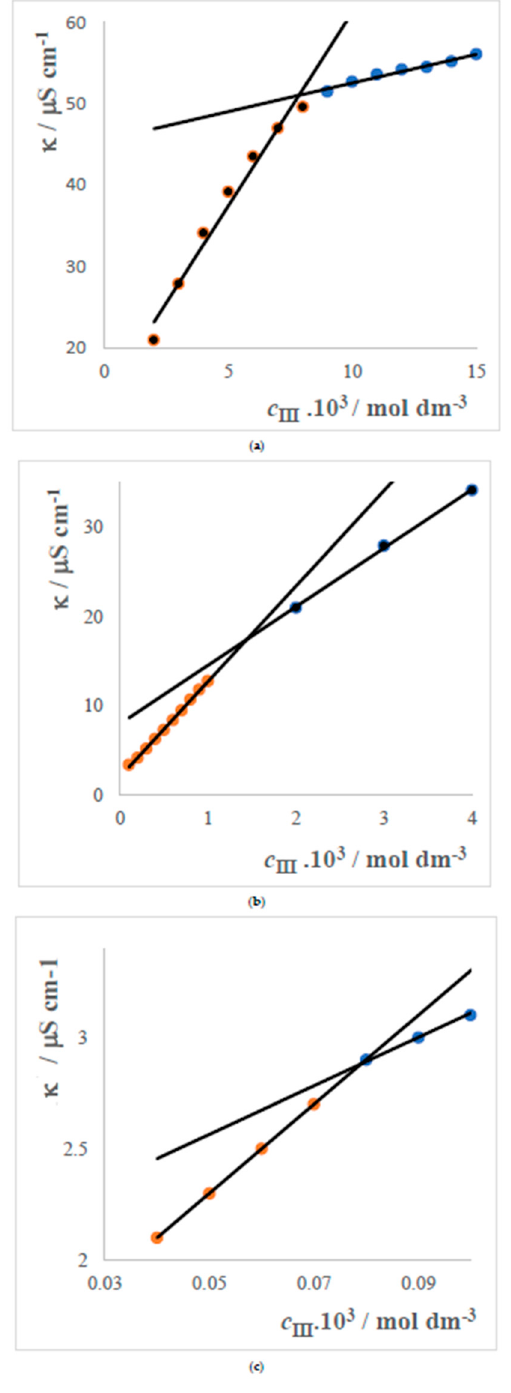
Figure 3. Conductivity curves of DDDMABr with values of CVCs at 25 °C. ( a ) CVC 1 = 7.96 × 10 − 3 mol dm − 3 ; ( b ) CVC 2 = 1.66 × 10 − 3 mol dm − 3 ; ( c ) CVC 3 = 0.079 × 10 − 3 mol dm − 3 .